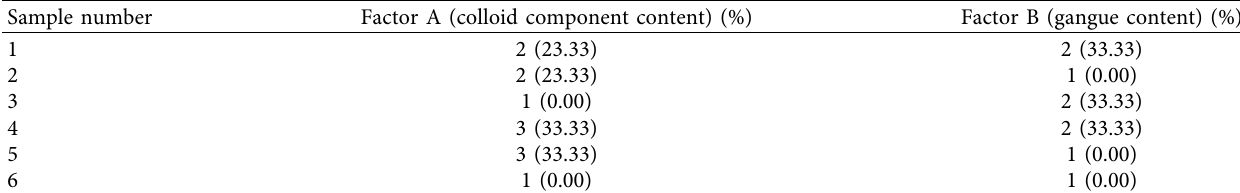
Table 4: Orthogonal tests.